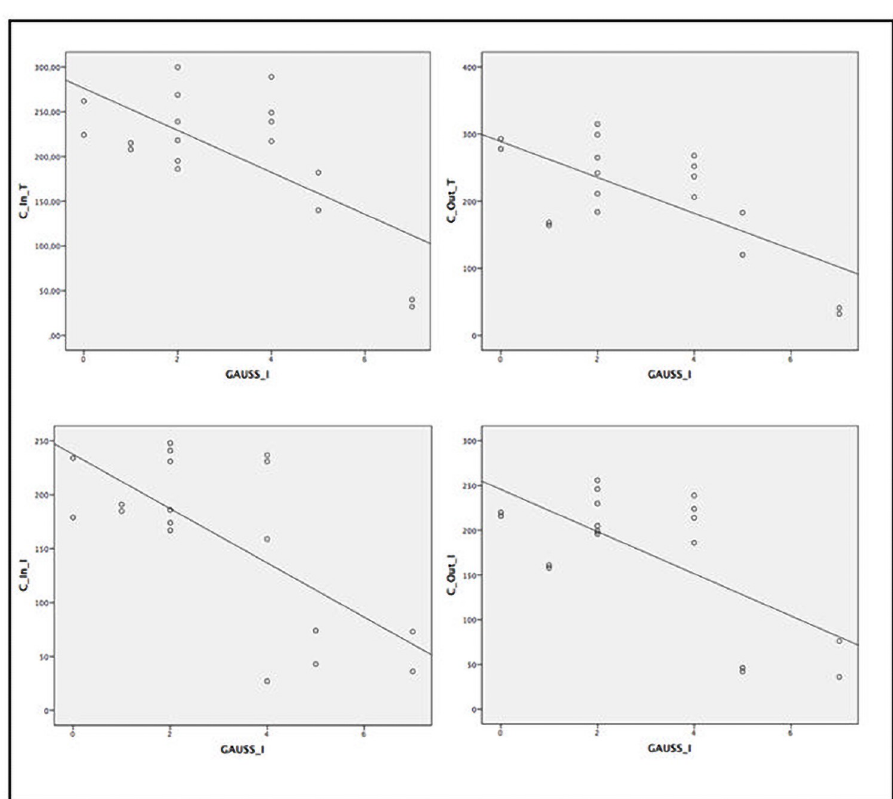
Fig 5. Moderate and strong correlation (r > 0.6) between choroidal thickness by SS-OCT and GauSSI-I score.